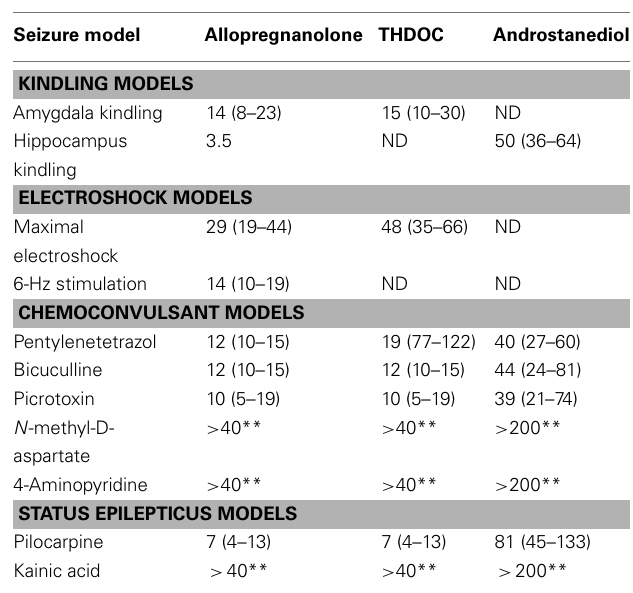
Table 1 |Antiseizure profile (ED 50 values) of endogenous neurosteroids in animal seizure